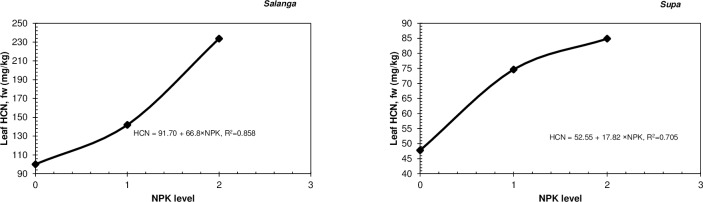
Models of HCN responses to increased NPK fertiliser application for each cassava variety in the pot experiment.Note that an ordinal scale was used to represent the fertiliser treatments and that; 0 = (N0P0K0), 1 = N1P1K1 and 2 = N2P2K2. Where; N0P0K0 = no fertiliser; N1P1K1 = 25 mg N + 5 mg P + 25 mg K /kg; N2P2K2 = 50 mg N + 13 mg P + 50 mg K /kg. Note that the sole K treatment (N0P0K1) has not been included in these analyses.